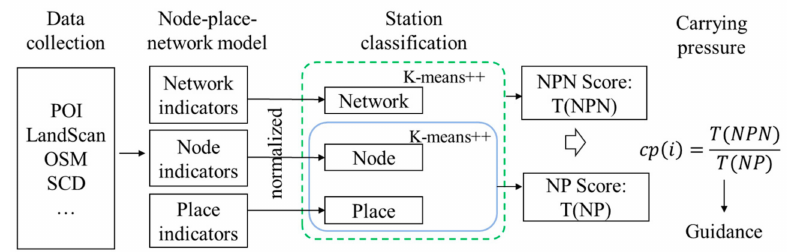
Figure 2. Research methodology (Taken Shanghai as case